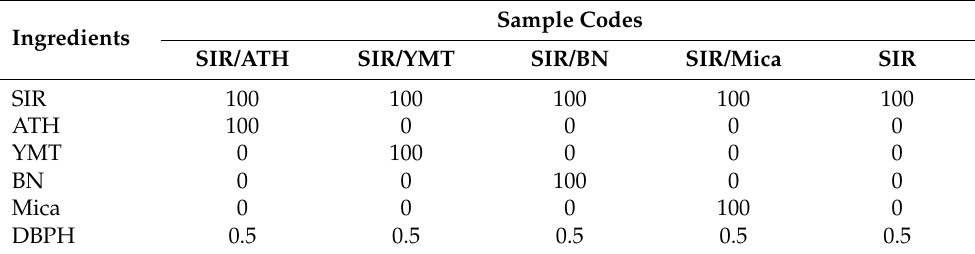
Table 1. Experimental formulation of SIR composites with various fillers (unit: phr, per hundred